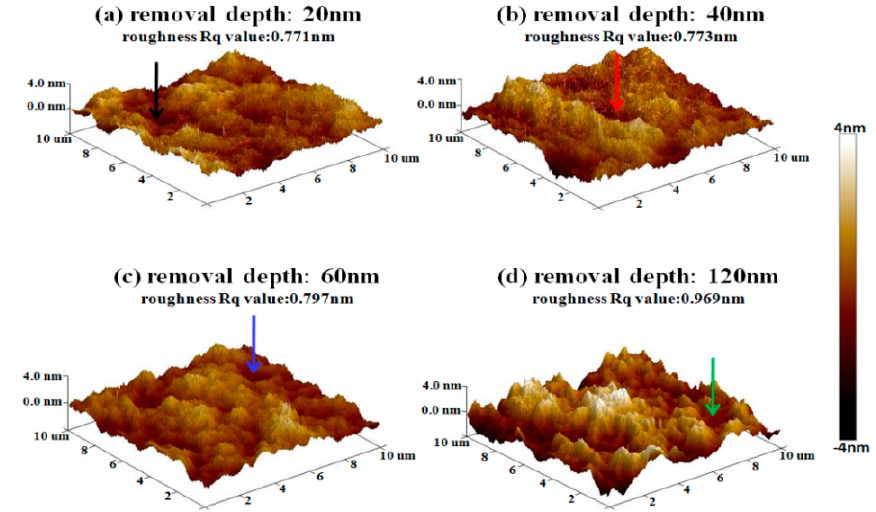
Figure 9. Morphology evolution of sample #2 in SAE preprocessing.